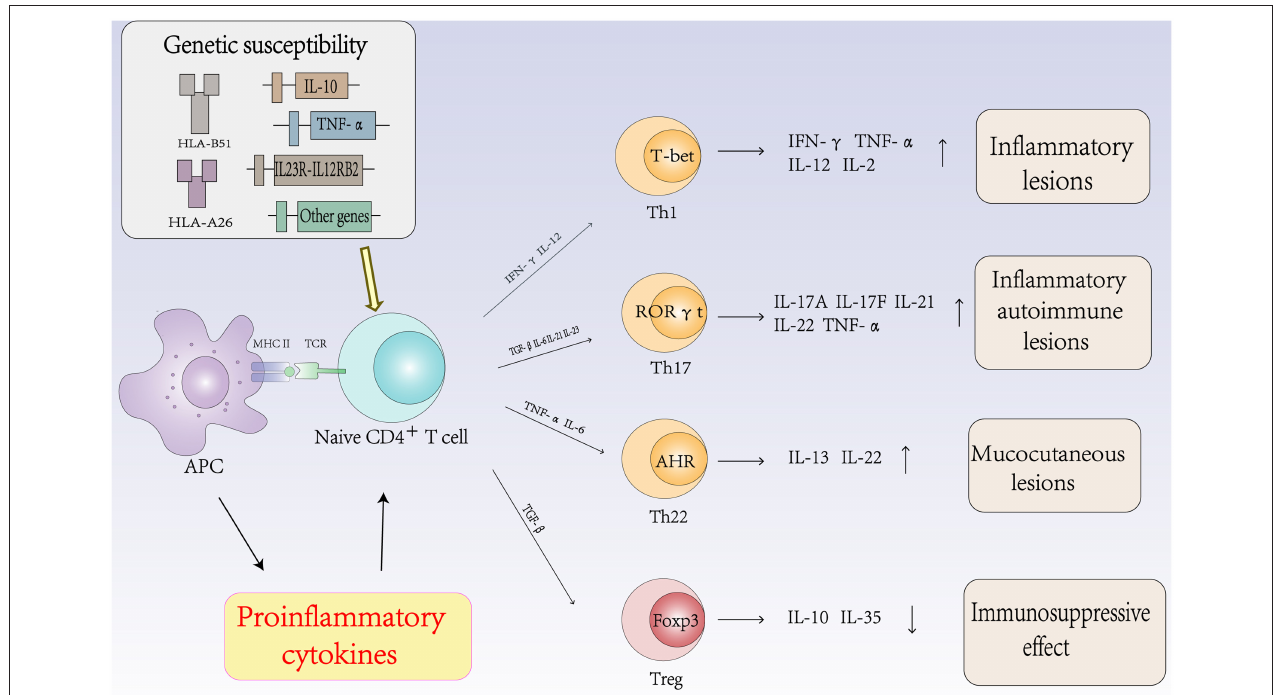
FIGURE 2 | The role of autoimmune T cells and cytokines in the pathogenesis of Behcet’s disease.